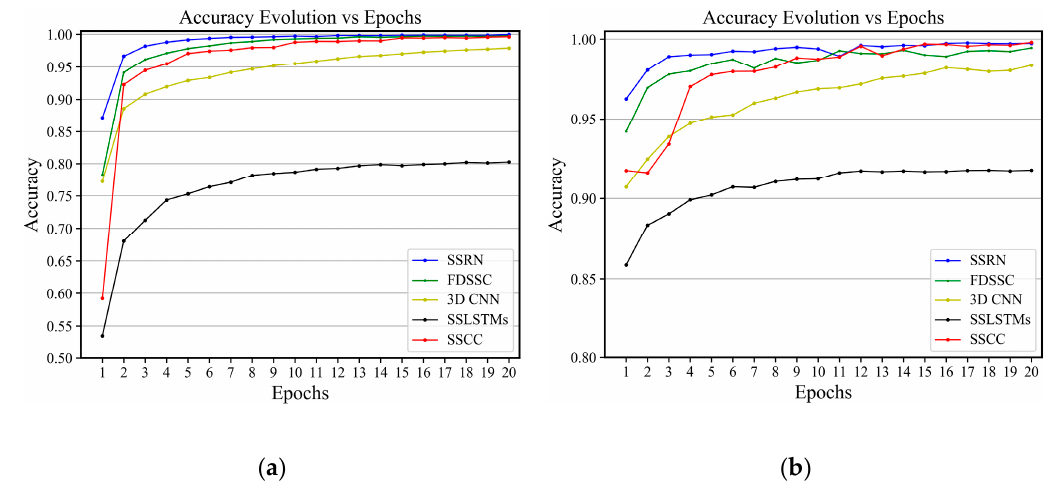
Figure 19. GF-5 datasets of Anxin County: Evolution of the accuracy in terms of epochs on ( a ) training data and ( b ) validation data.